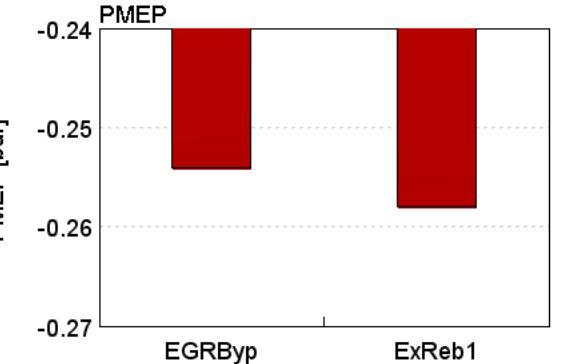
Figure 21. PMEP comparison between EGRByp and ExReb1 for Tivc 404 K at B10.